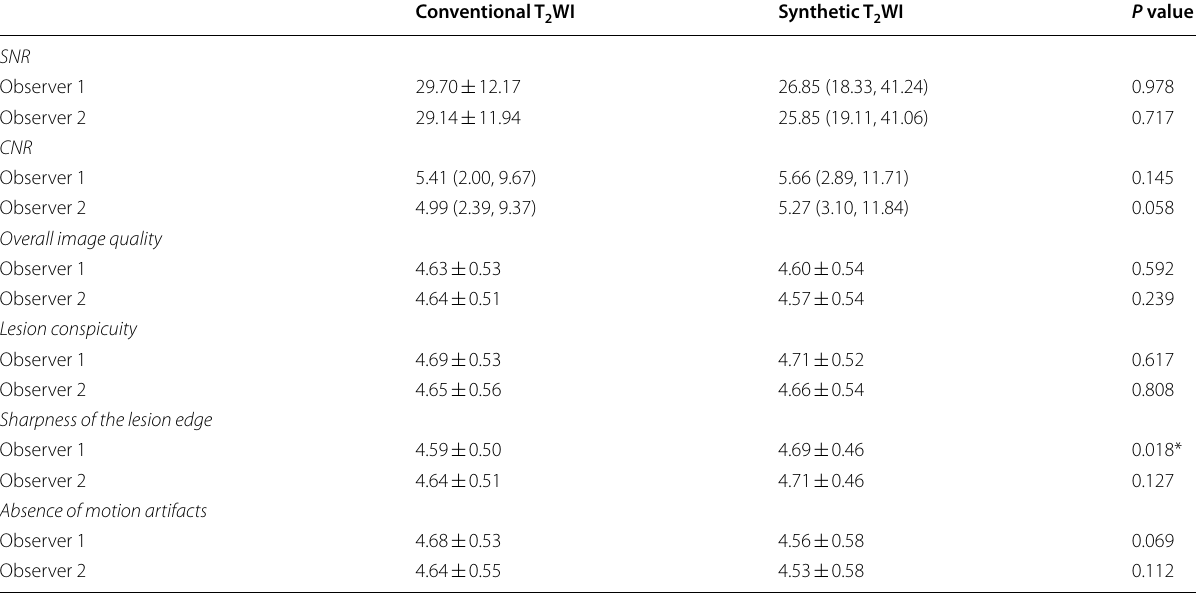
SNR and CNR following the normal distribution are expressed as mean standard deviation; otherwise, expressed as median (first quartile, third quartile). The subject ± image scores are expressed as means standard deviations ± SNR, signal-to-noise ratio; CNR, contrast-to-noise ratio